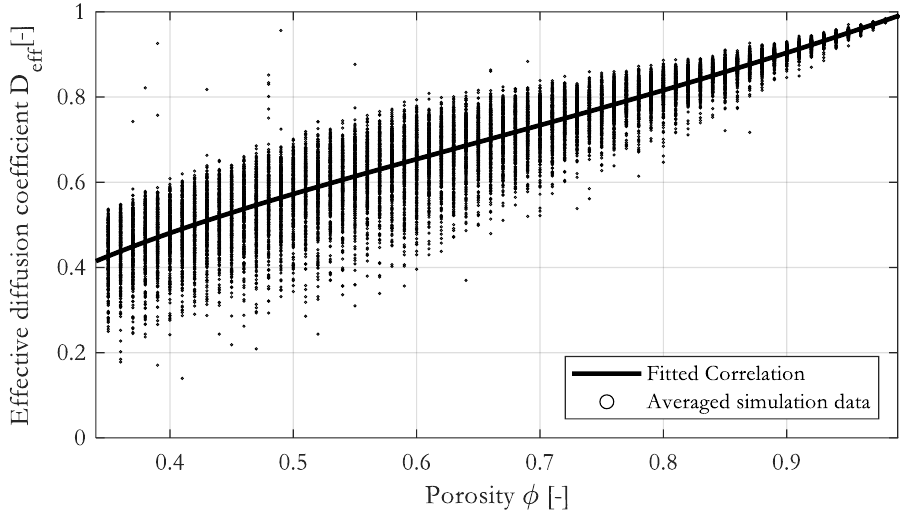
Figure 12. Constitutive diffusion – porosity correlation and simulation data.